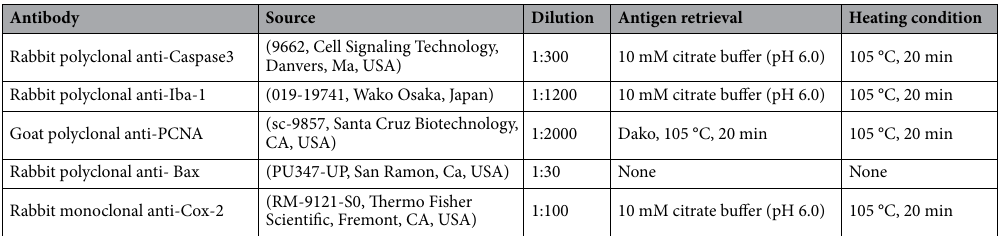
Table 1. List of antibodies, sources, working dilutions, and methods for antigen retrieval.